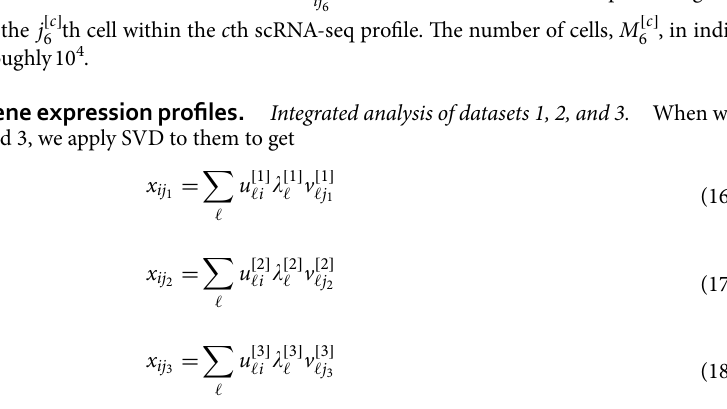
Dataset 6: GSE163577. This is an scRNA-seq dataset 28 denoted as 6 (i.e., k = 6 ) in this study, including both AD patients. 25 individual datasets are formatted as a matrix, x